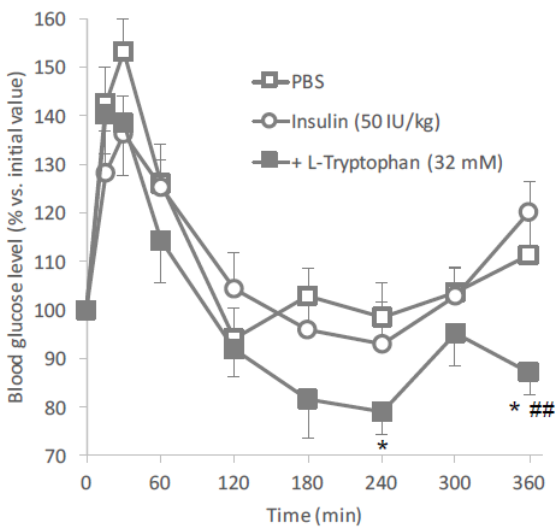
Figure 2. Blood glucose levels in mice following oral administration of insulin (50 IU/kg) with or without L -tryptophan (32 mM). Each data point represents the mean ± SEM of N = 6–8. * p < 0.05, ## p < 0.01, significantly different with PBS and insulin (50 IU/kg), respectively.